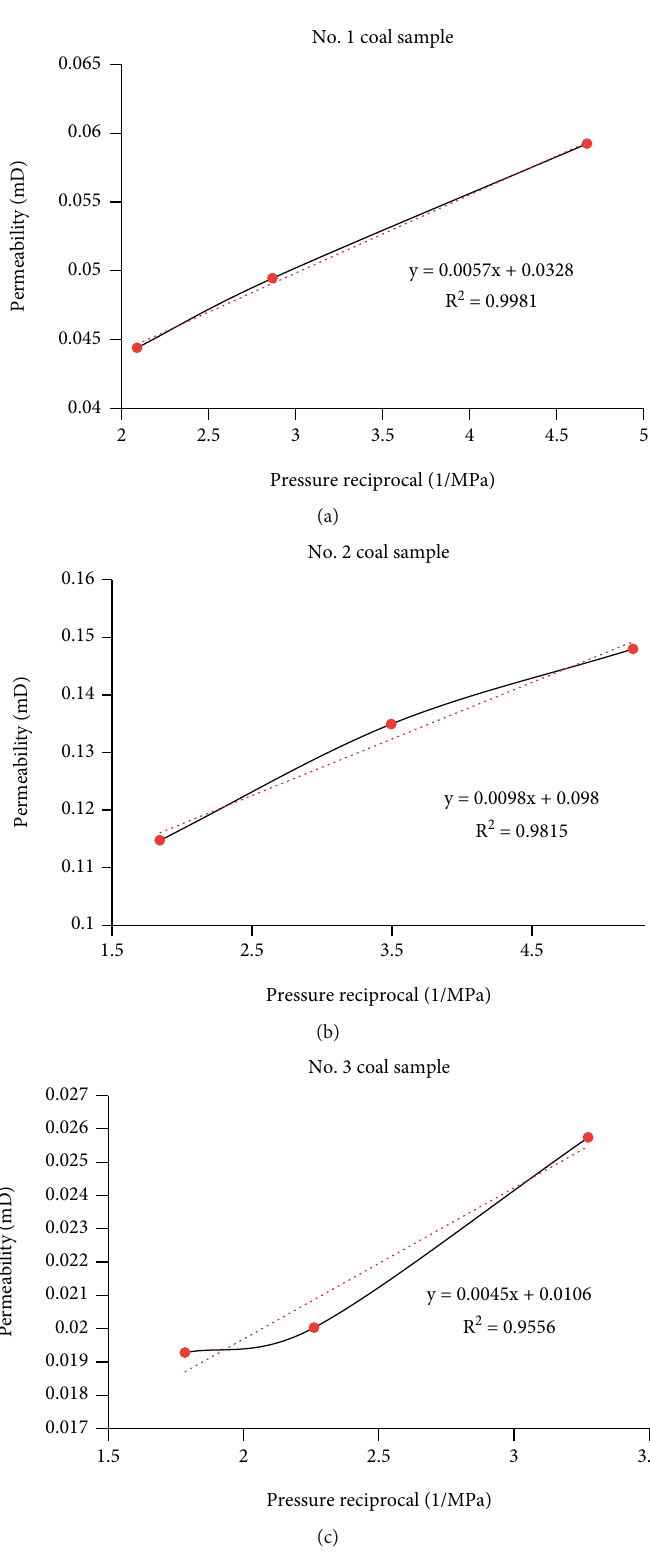
Figure 3: Relationship between permeability and pressure